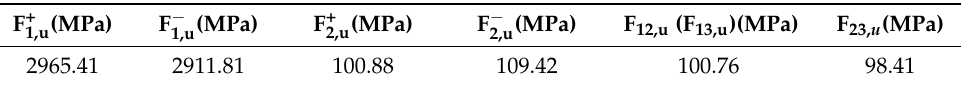
Table 2. The strength of the lamina.